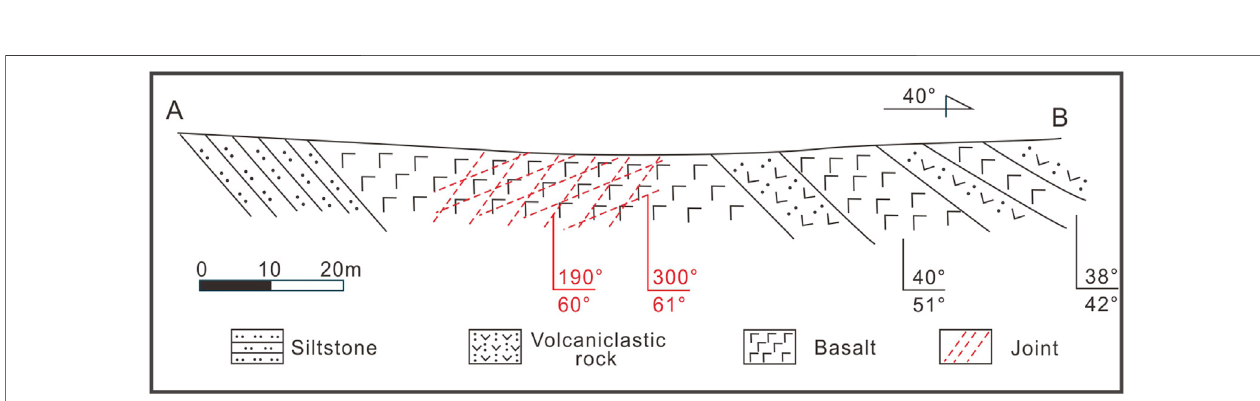
FIGURE 4 | Geological section of Longlin basalt among the Linghao Formation.